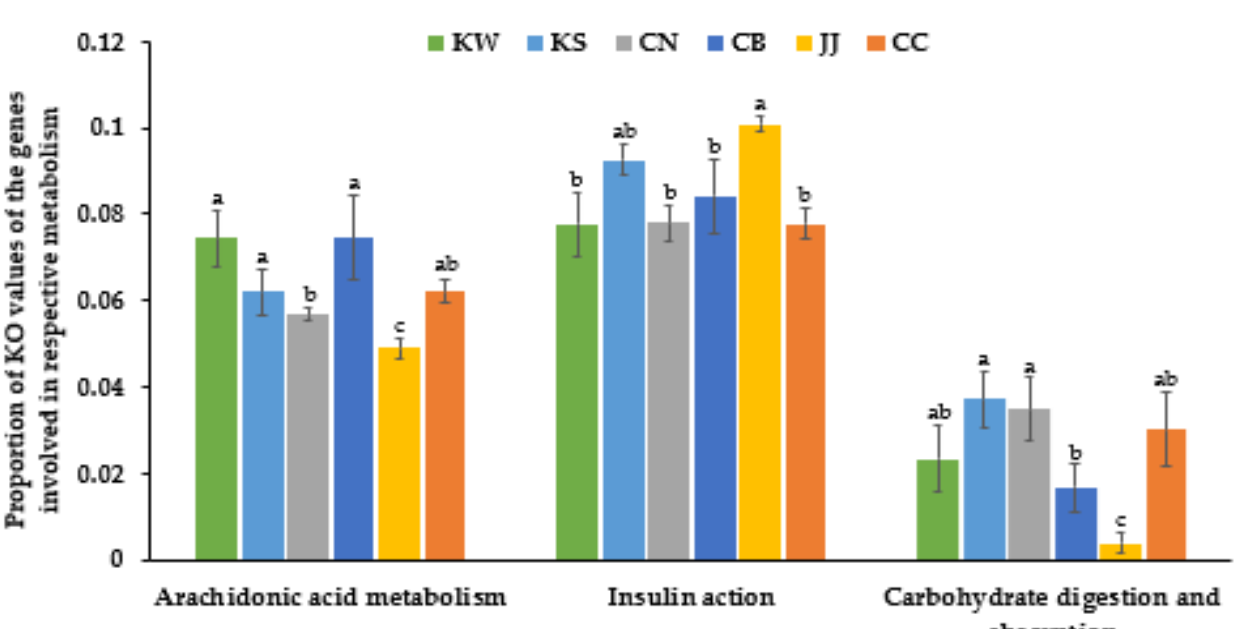
Figure 5. The relative abundance of the bacteria genes related to metabolic functions in traditionally made doenjang (TMD). Their relative abundance was calculated using the Kyoto Encyclopedia of Genes and Genomes Orthology (KO). TMD samples from Chonbuk (CB), Chonnam (CN), Kyungsang (Kyungbuk + Kyungnam; KS), Kangwon (KW), Chungcheung (Chungbuk + Chungnam; CC), and Jeju island (JJ). ( a – c )—Different letters on the bars indicate significant differences between the groups by Tukey test ( p < 0.05).